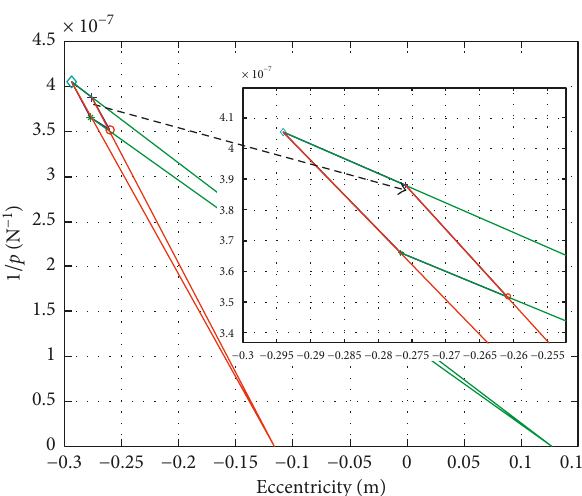
Figure 3: Magnel design diagram in the midspan cross section.